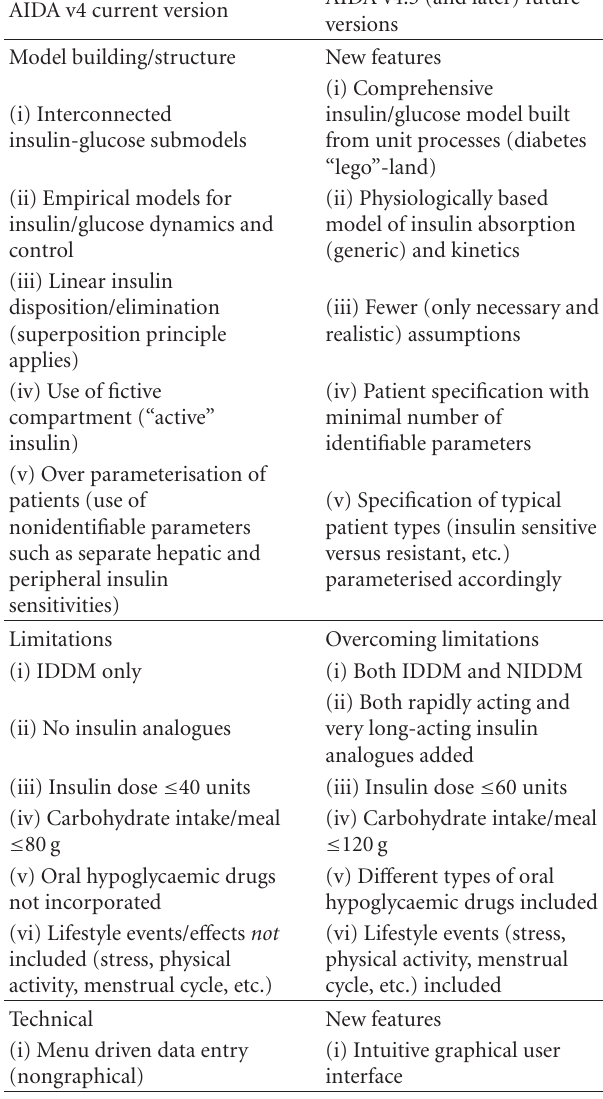
Table 1: Comparison of features in current release of AIDA v4 dia- betes simulator (on left) with planned features in future versions of the software (v4.5) and later (on right). IDDM: insulin-dependent (type 1) diabetes mellitus. NIDDM: non-insulin-dependent (type 2) diabetes mellitus.